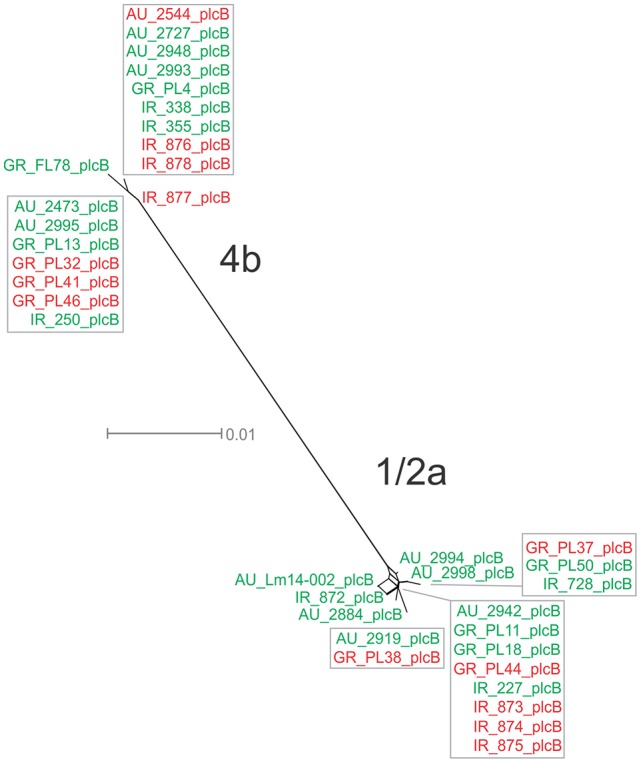
Phylogenetic network applied to virulence gene plcB using the Neighbor-Net algorithm. L. monocytogenes strains represented food environment isolates (green color) or clinical isolates (red color), isolated in Ireland (IR), Greece (GR), and Australia (AU). Strains clustered together in a box represent identical nucleotide sequence.